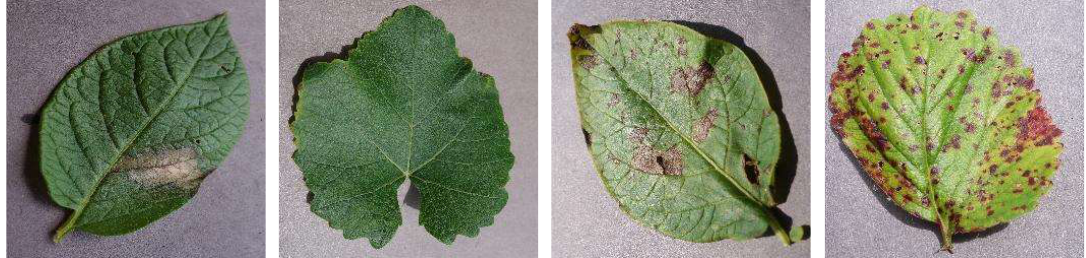
Figure 1. Sample images from random classes of the original dataset.